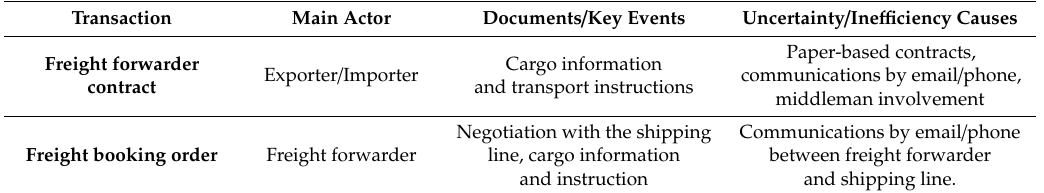
Table 4. Overview of transactions in pre-carriage logistics in the status quo (developed by the